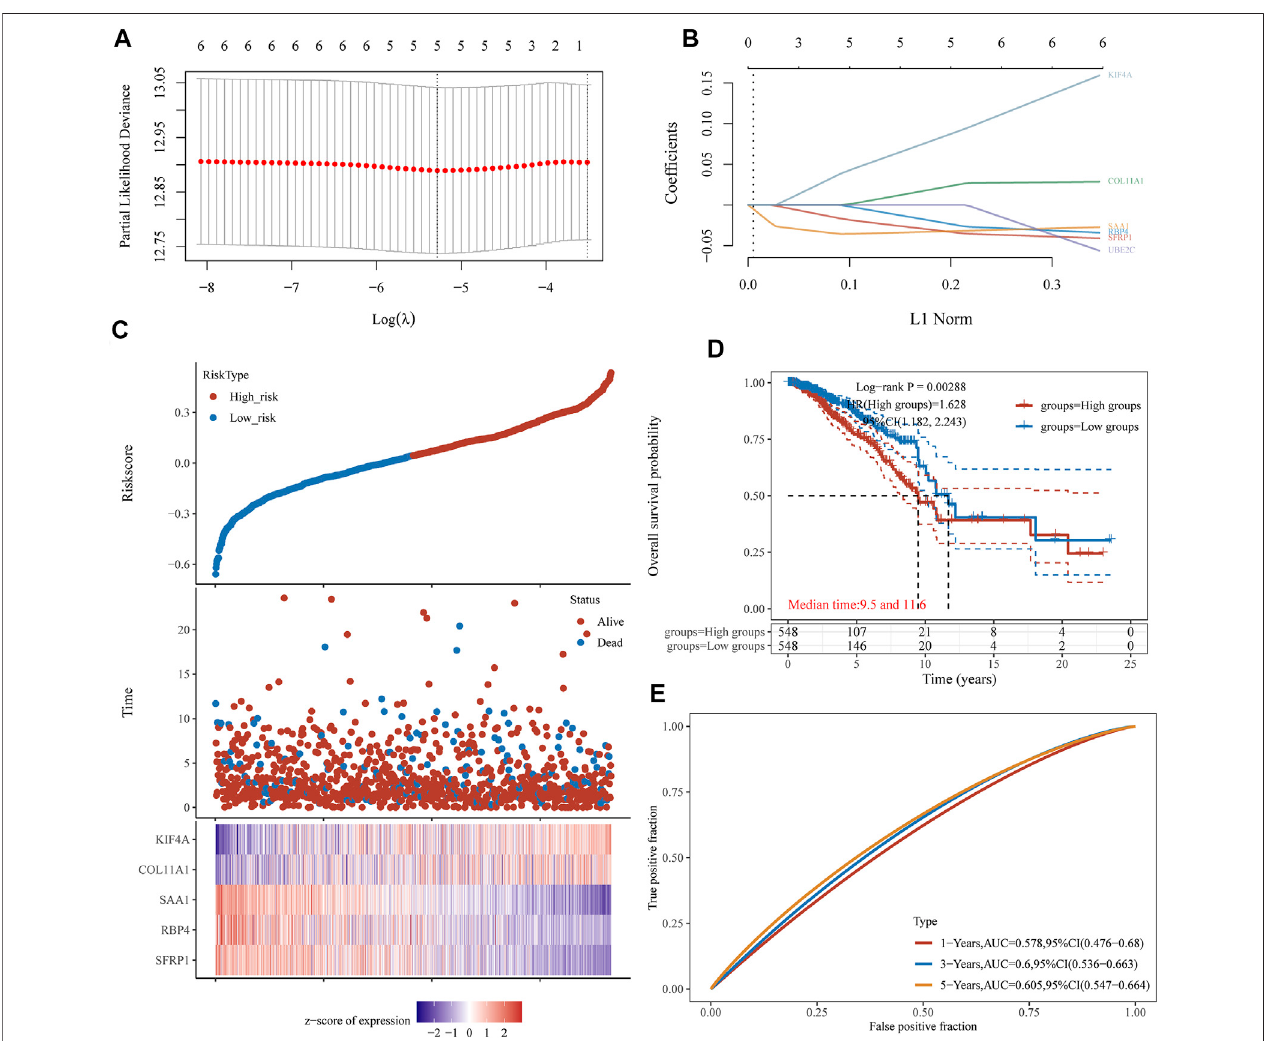
FIGURE 5 | LASSO regression analysis of TCGA datasets identi fi es a fi ve-gene risk pro fi le for overall survival . (A) Adjustment of the proportional hazards model ’ s tuning parameters using cross-validation. (B) Scan of six BC genes with the LASSO coef fi cient spectrum. (C) Patient survival and BC status, as well as risk score distribution. (D) Kaplan-Meierwasusedtocategorisepatientsbasedontheirmedianriskofdeveloping BC. (E) Therisksignature ’ spredictivepower wasdemonstrated using ROC